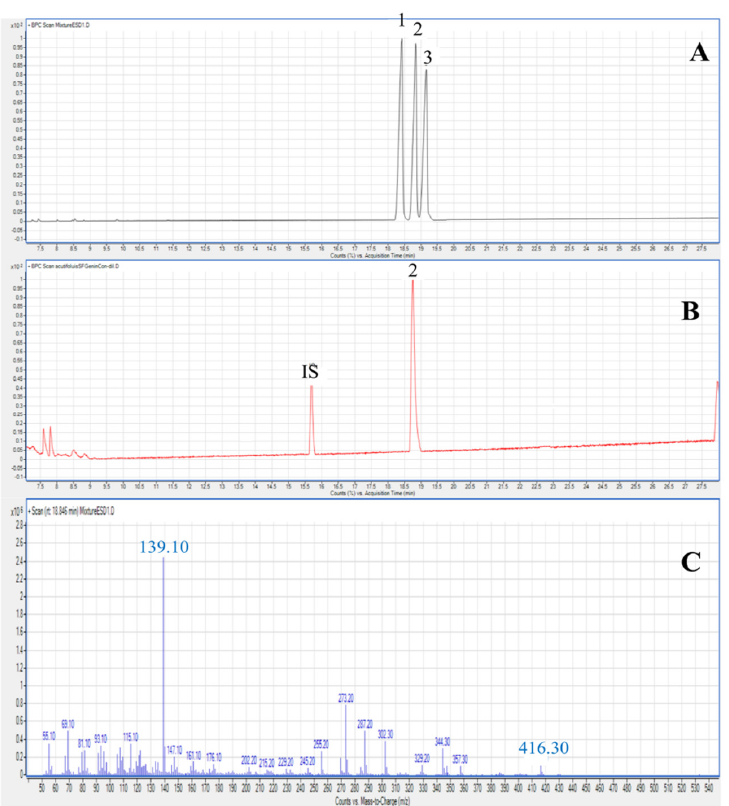
Figure 1. Chromatographic profile acquired by GC-MS of genin standards ( A ), hydrolyzed acid of saponin fraction of A. acutifolius organs ( B ) and mass spectra of sarsasapogenin ( C ). 1: Esmilagenin, 2: Sarsasapogenin, 3: Diosgenin, IS: Internal standard cholesterol.